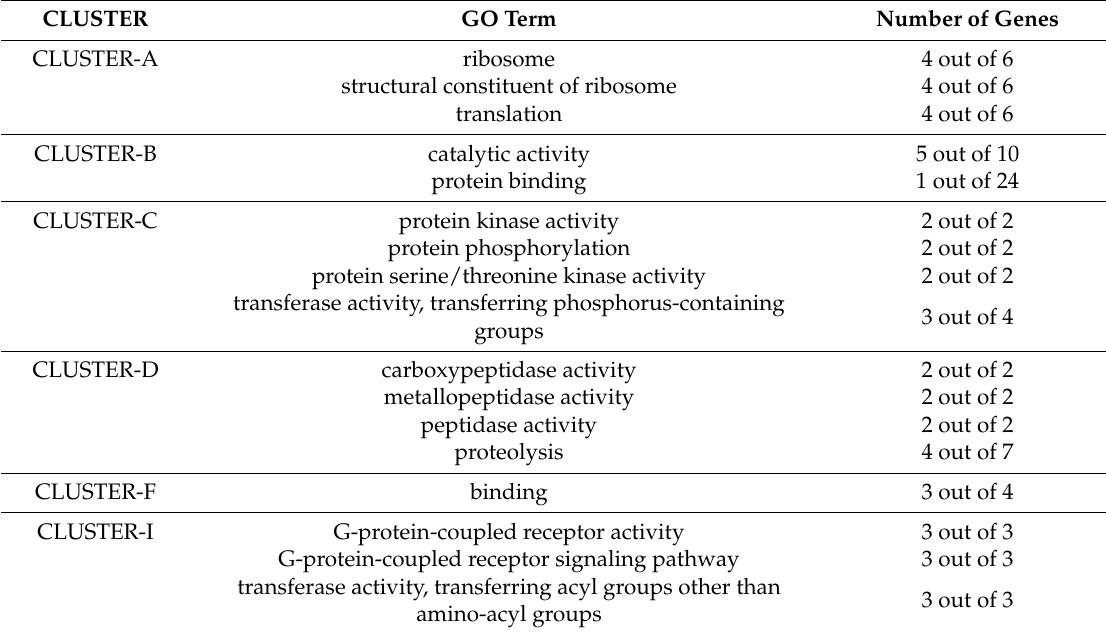
Table 3. Functional annotation of genes of predicted clusters. The number of DEGs associated with the GO in comparison to the total cluster genes of the same GO term is shown.